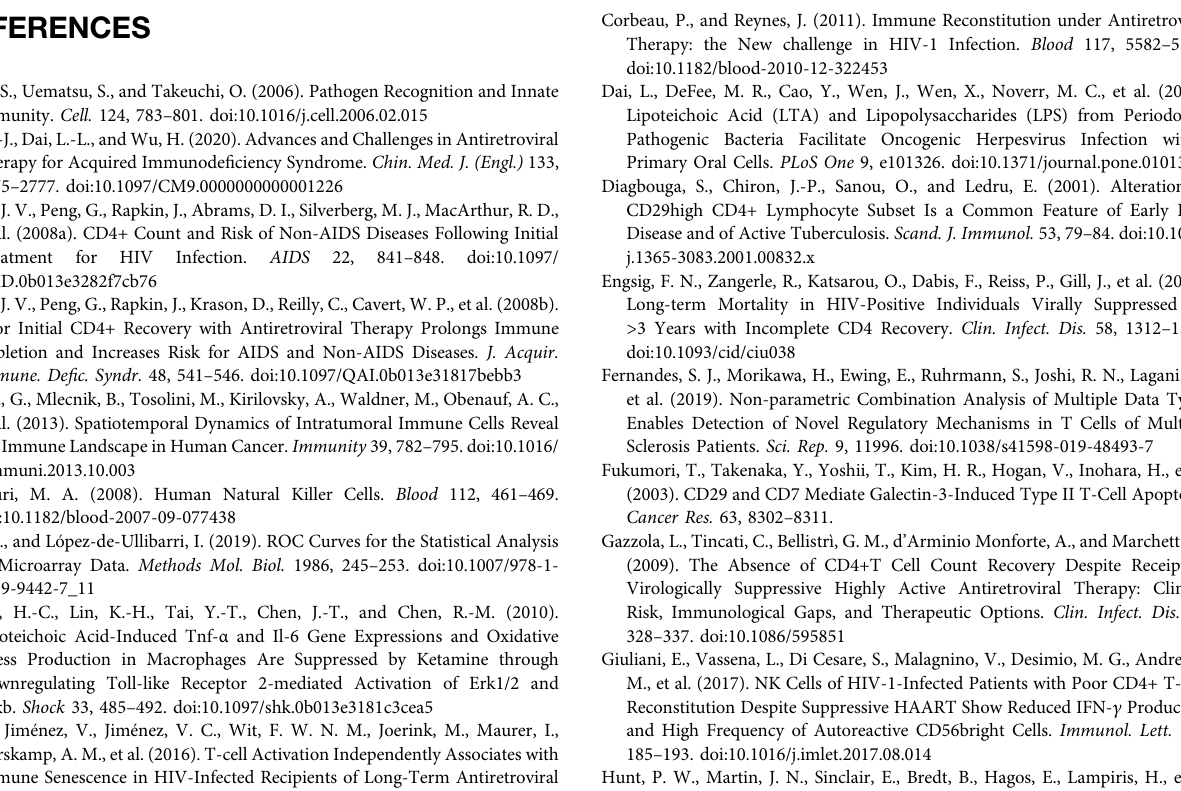
Supplementary Figure 1 | The batch effect correction of the GSE106792 and GSE77939 datasets. (A) The distribution of samples before correlation in the GSE106792 and GSE77939 datasets. (B) The distribution of samples after correlation in the GSE106792 and GSE77939 datasets. (C) The distribution of INRs and IRs after